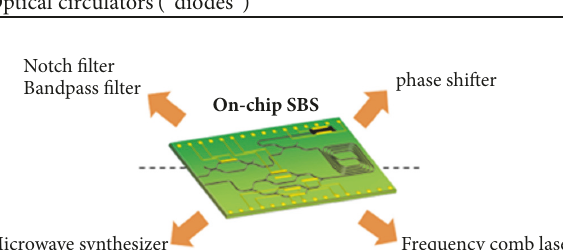
Figure13:Conceptforoptophonics,afieldwhichcomesaboutfrom extendingphotonics by incorporatingphonons as well as electronics into the field of integrated optics [adapted from